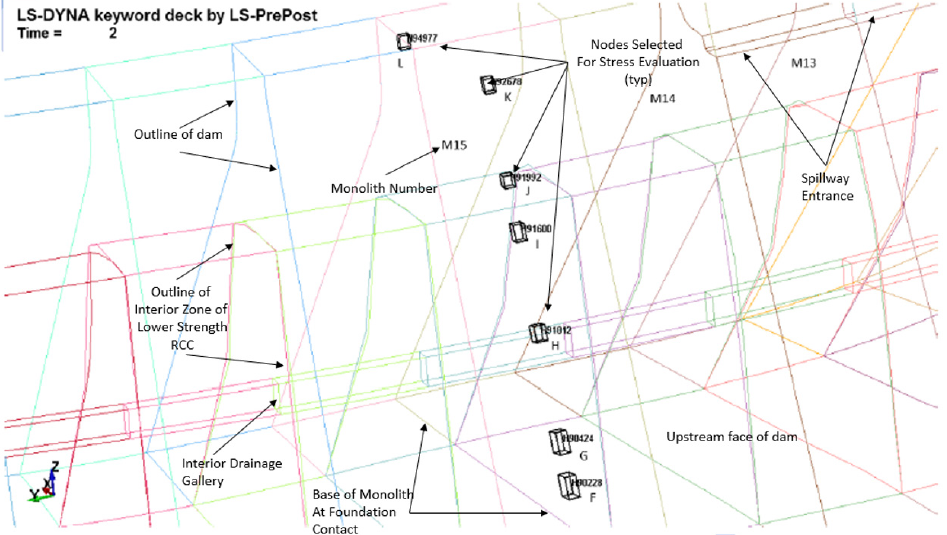
Figure 9. Location of nodal points along the upstream face of monolith 15 corresponding to stress response plot in Figure 8. Different colored lines in the plot represent the boundaries of the monoliths formed by the TCJs in the dam model. Perspective is looking from the reservoir toward the upstream face of the dam.